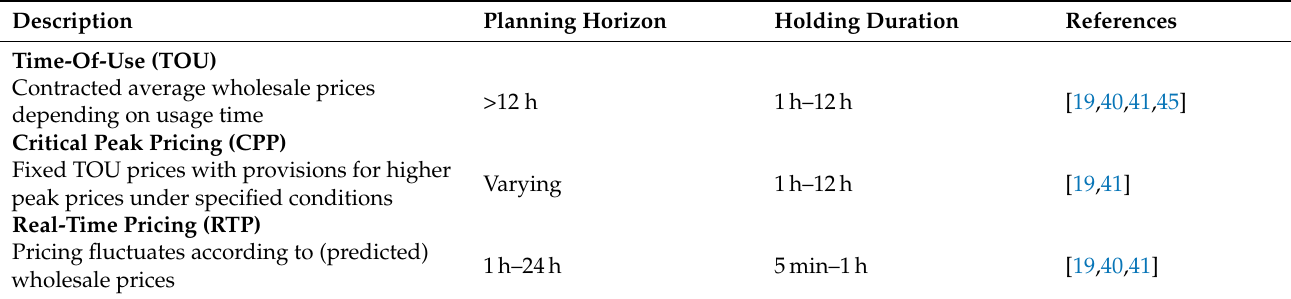
Table 2. Price-based Demand Response (DR) program